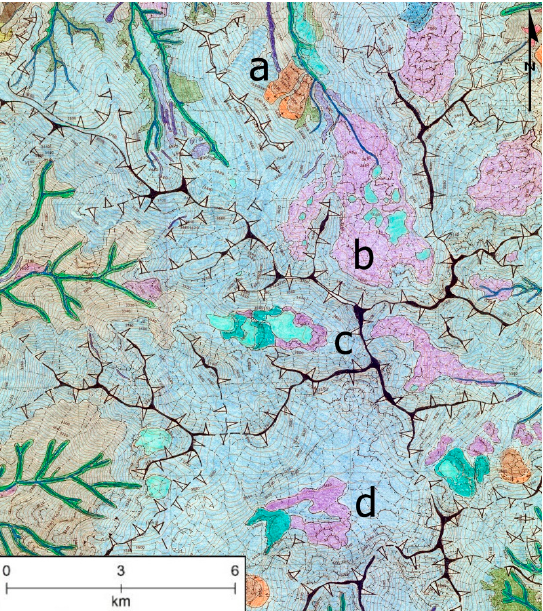
Figure 4. Classical glacial geomorphology of the Cerro Chirripó in Costa Rica. ( a ) Lateral moraine, ( b ) till deposits, ( c ) arêtes, ( d ) periglacial dynamics. More details and locations can be seen in Quesada-Román et al. [68] and Quesada-Román and Zamorano [69].